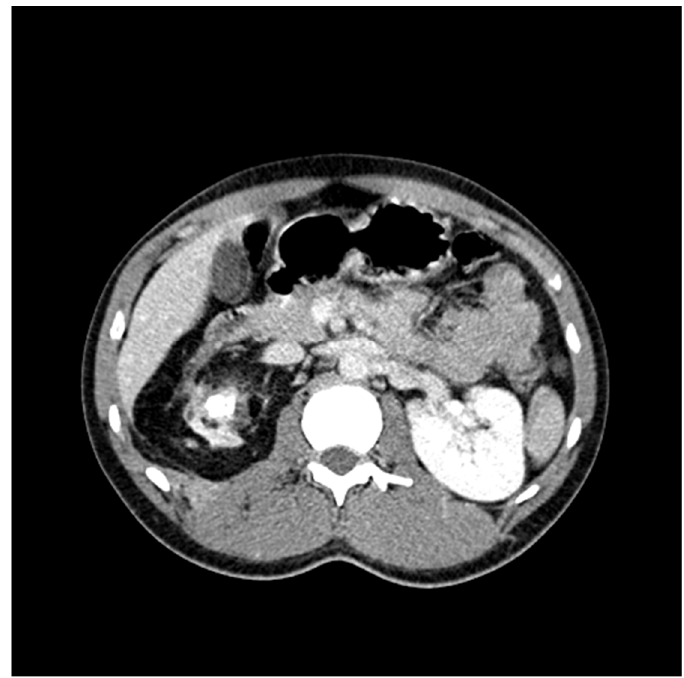
Figure 3. CT Scan showing perinephric edema mimicking pyelonephritis.